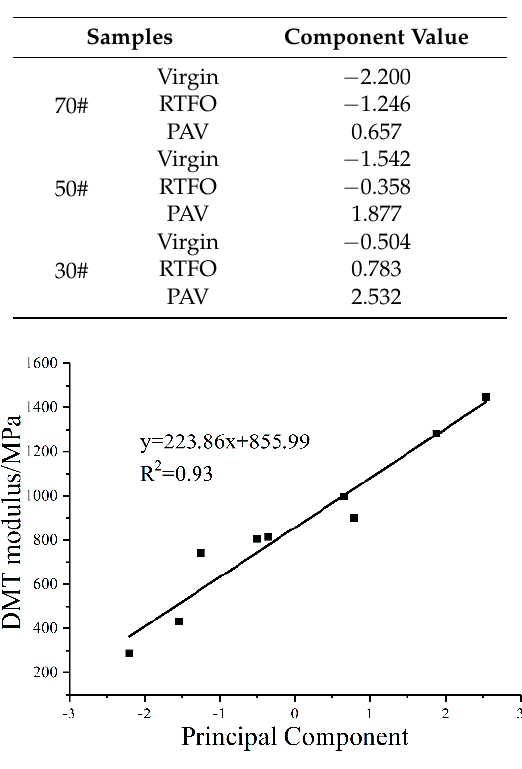
Figure 6. Relationship between the principal component and DMT modulus.